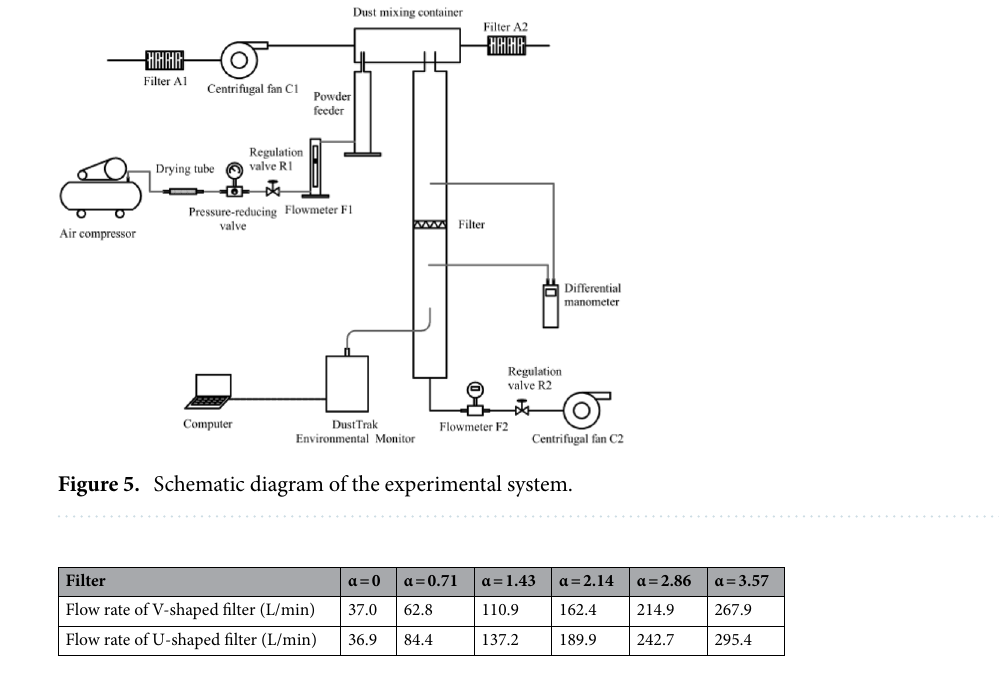
Table 3. Flow rates when the filtration velocity is 4